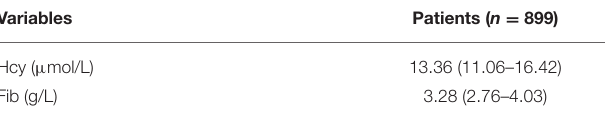
TABLE 1 | Baseline characteristics of the study